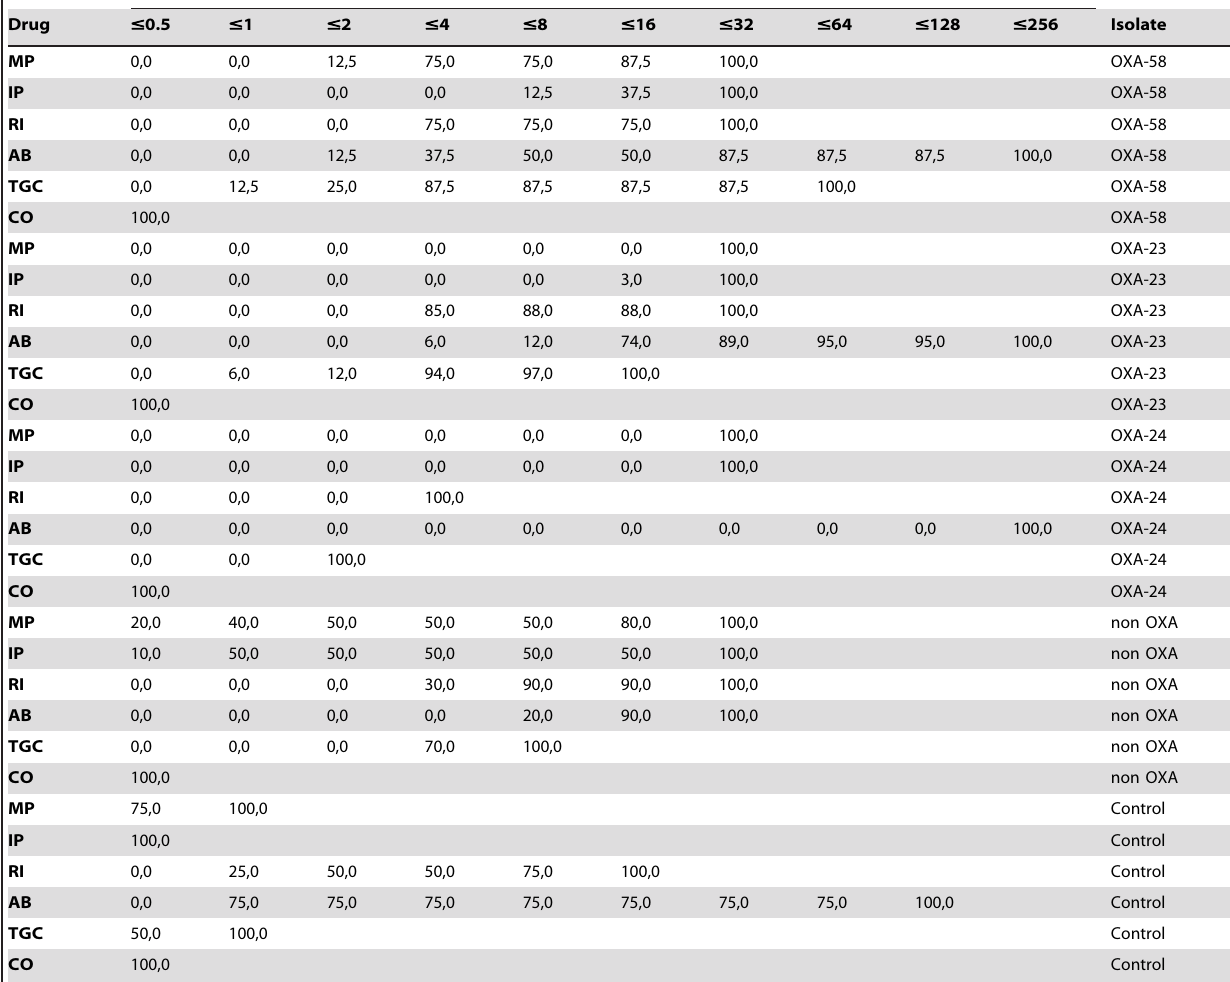
Cumulative percentage of isolates inhibited at MIC (mg/l) value